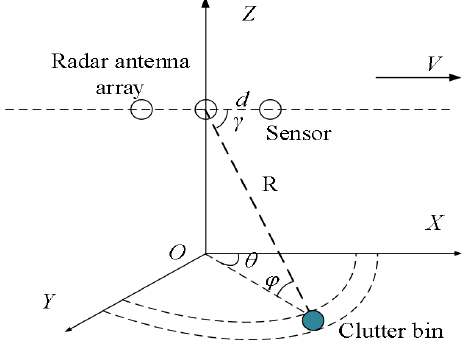
Figure 1. The earth observation geometry of an airborne radar